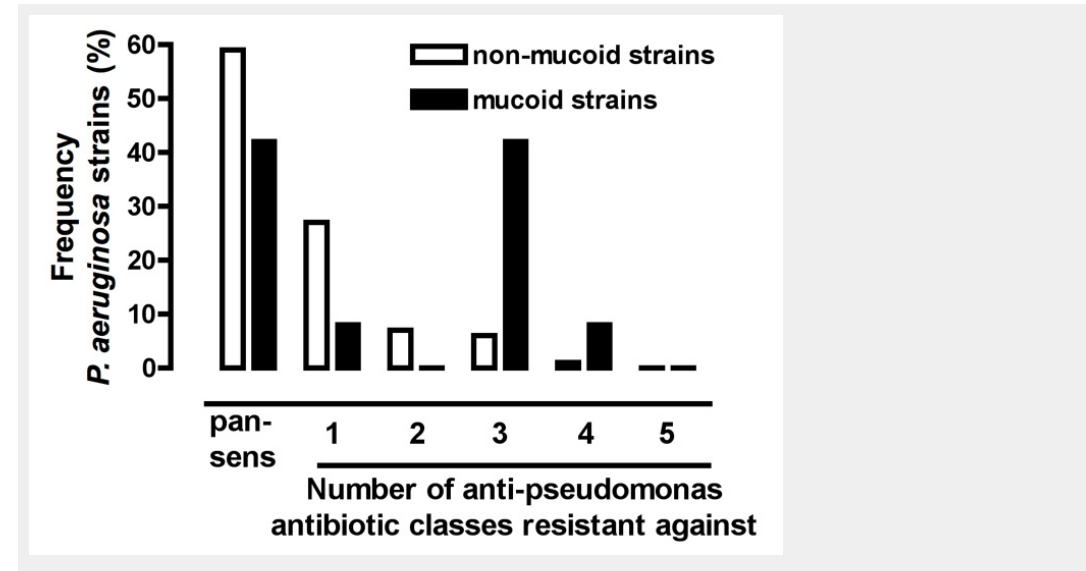
Figure 5 Frequency of resistances against 5 anti-pseudomonas antibiotic classes in 112 COPD patients, all colonised with non-mucoid (n = 112) and some additionally with mucoid (n = 12) P. aeruginosa strains . The anti-pseudomonas antibiotic classes tested are detailed in the Methods section and in table 1. Pan-sens, pan-sensitive P. aeruginosa isolates.